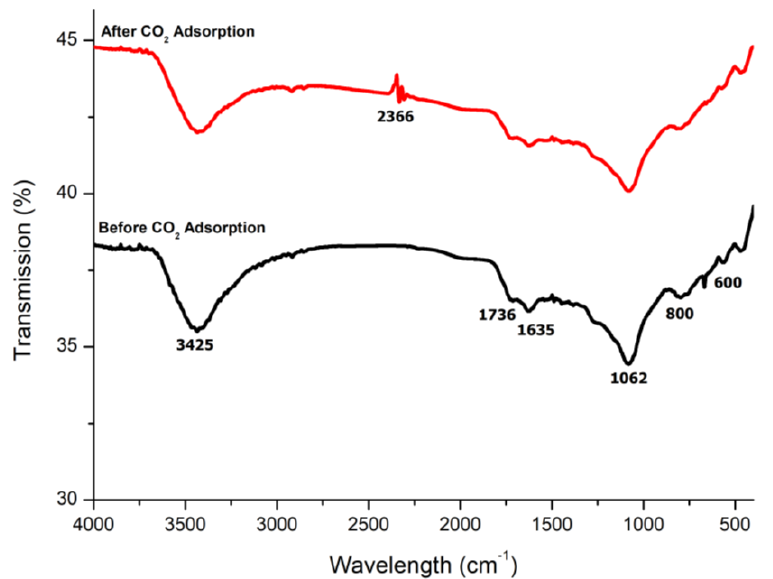
Figure 10. FTIR analysis of RSS-IL 800 before and after CO 2 adsorption.